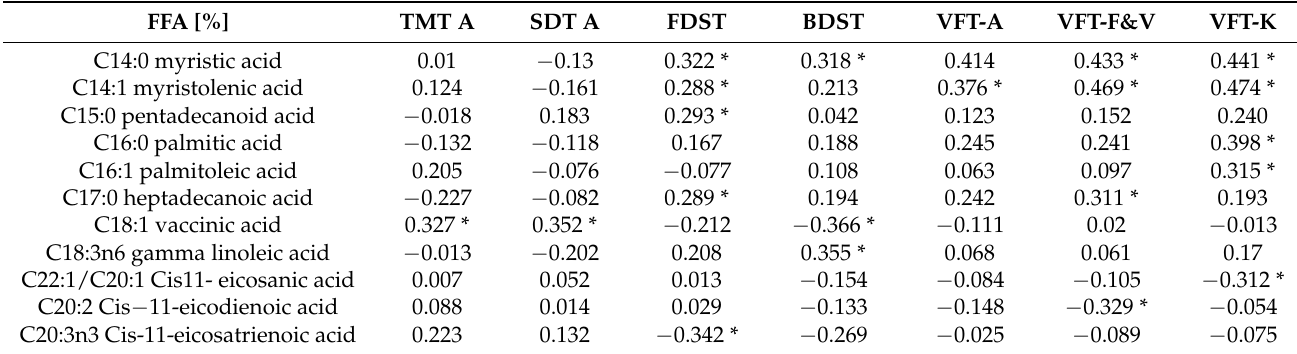
Table 4. The correlations between FFAs and results of neuropsychological tests performed on the 7th day after stroke (TMT A, SDT A, FDST, BDST, VFT-A, VFT-F&V, VFT-K, VFT-P).